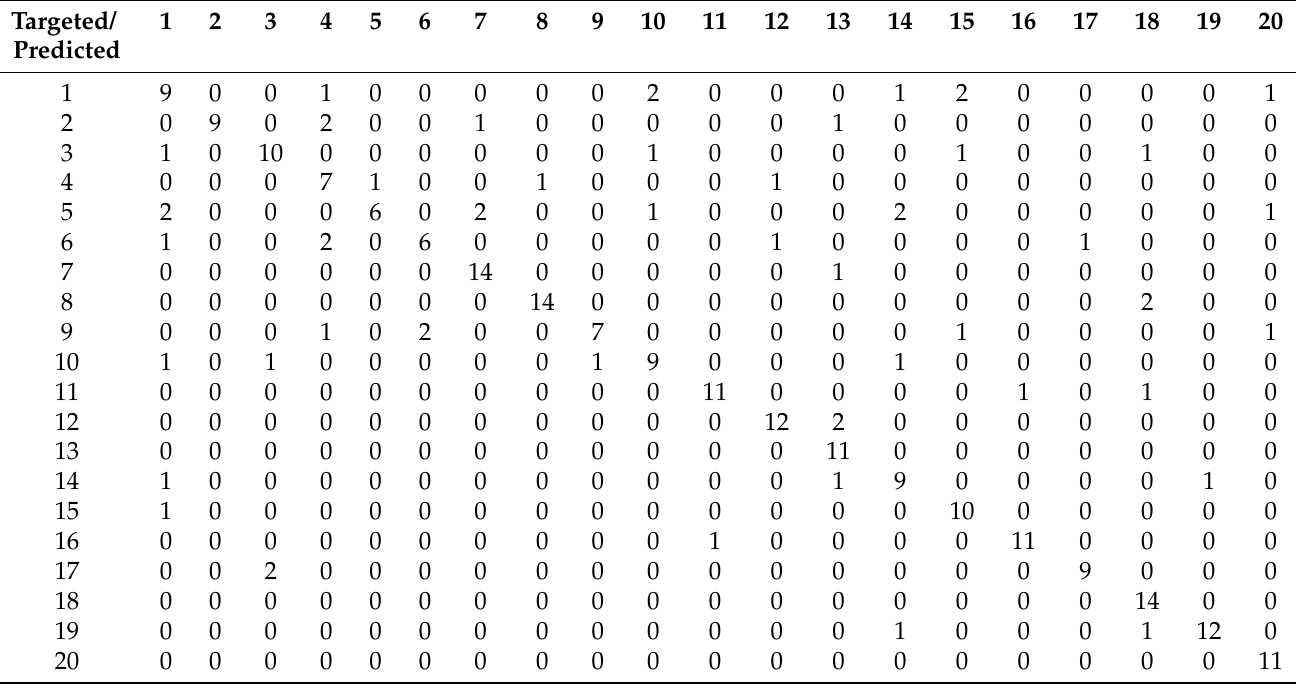
Table 5. The example of the confusion matrix for